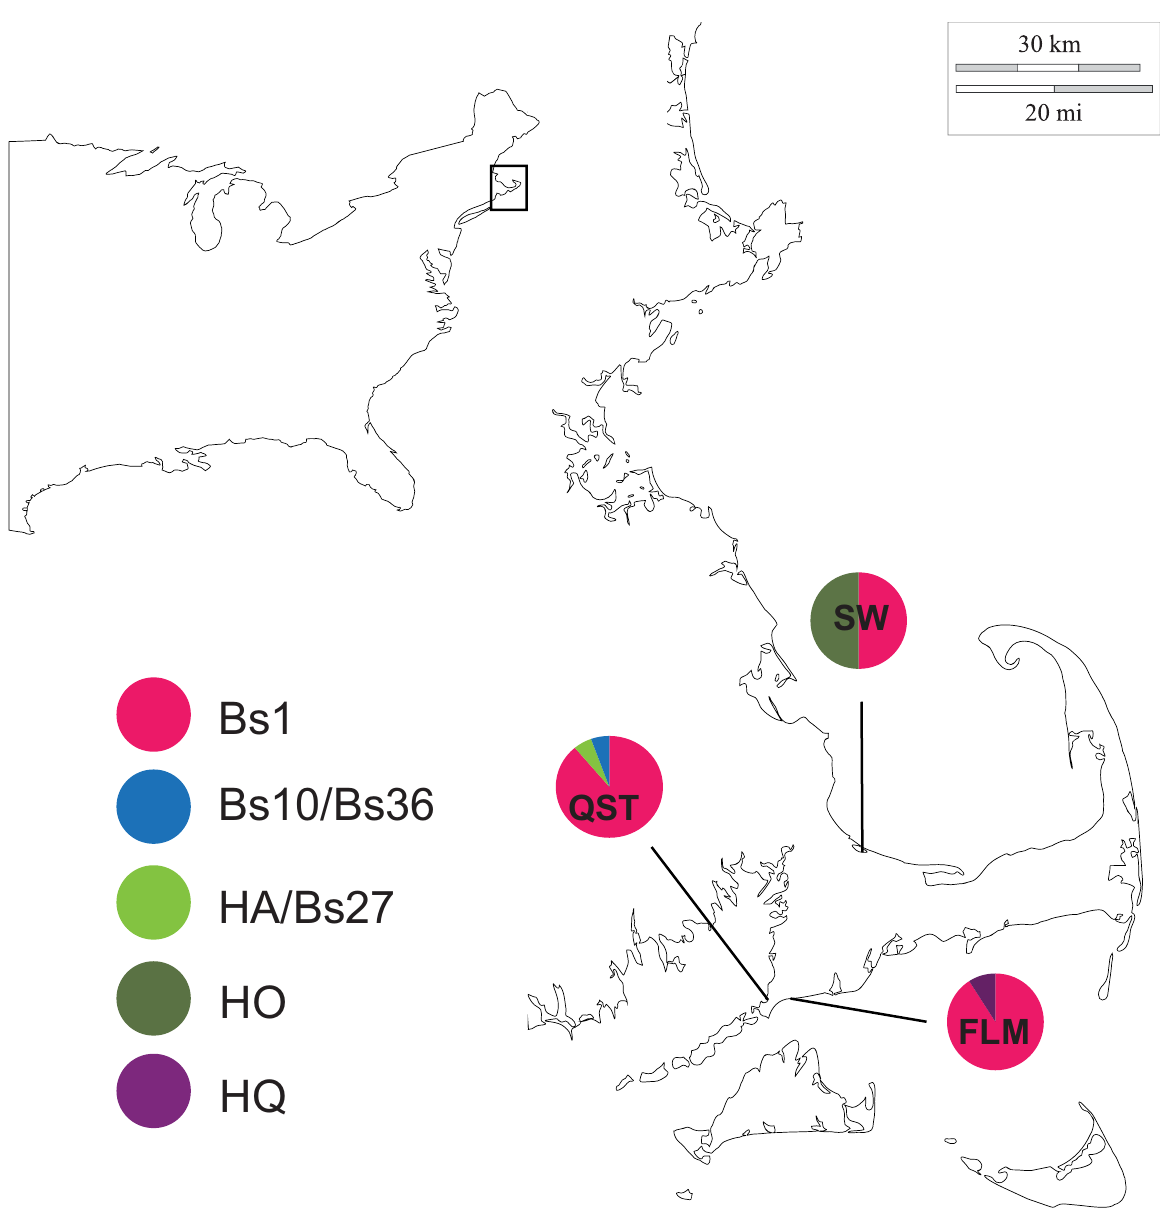
Fig 4. Clade A haplotype frequencies in the northwestern Atlantic populations sampled by the authors of this study. The populationabbreviations are as follows: FLM = Falmouth, MA, USA; QST = Quissett, MA, USA; SW = Sandwich,MA,